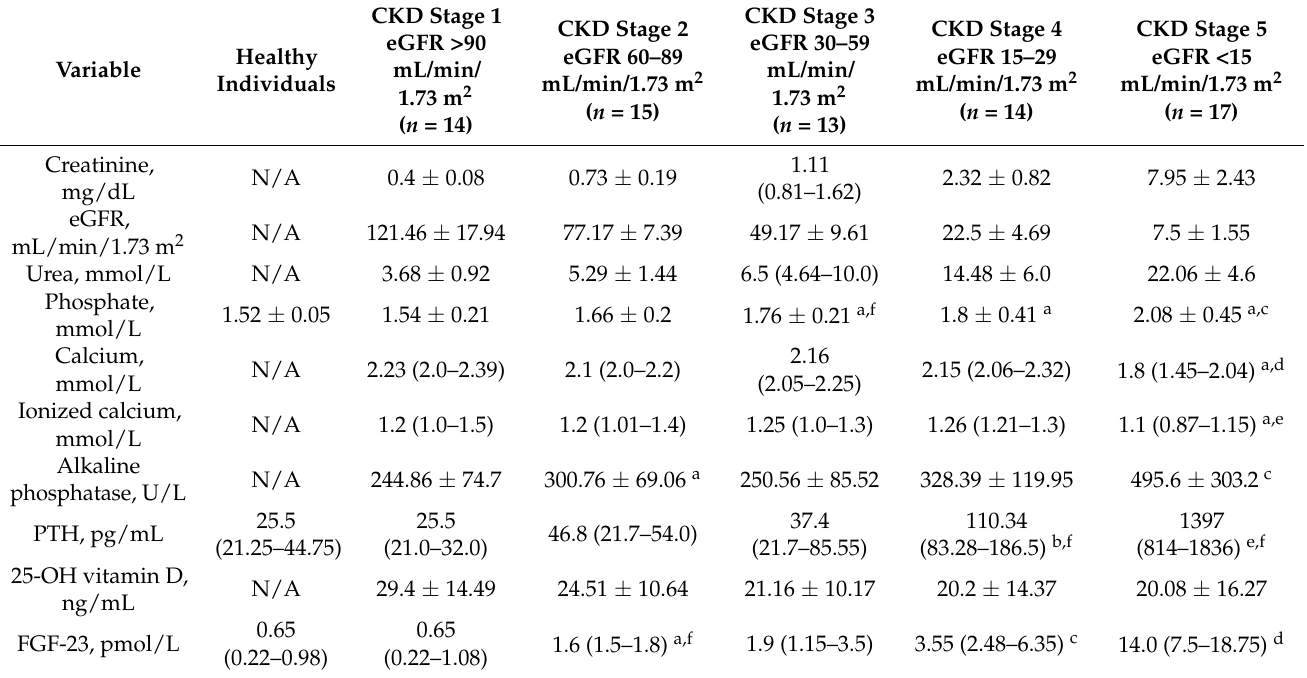
Table 2. Laboratory variables of patients according to different stages of CKD. CKD, chronic kidney disease; eGFR, estimated glomerular filtration rate; PTH, parathyroid hormone; FGF-23, fibroblast growth